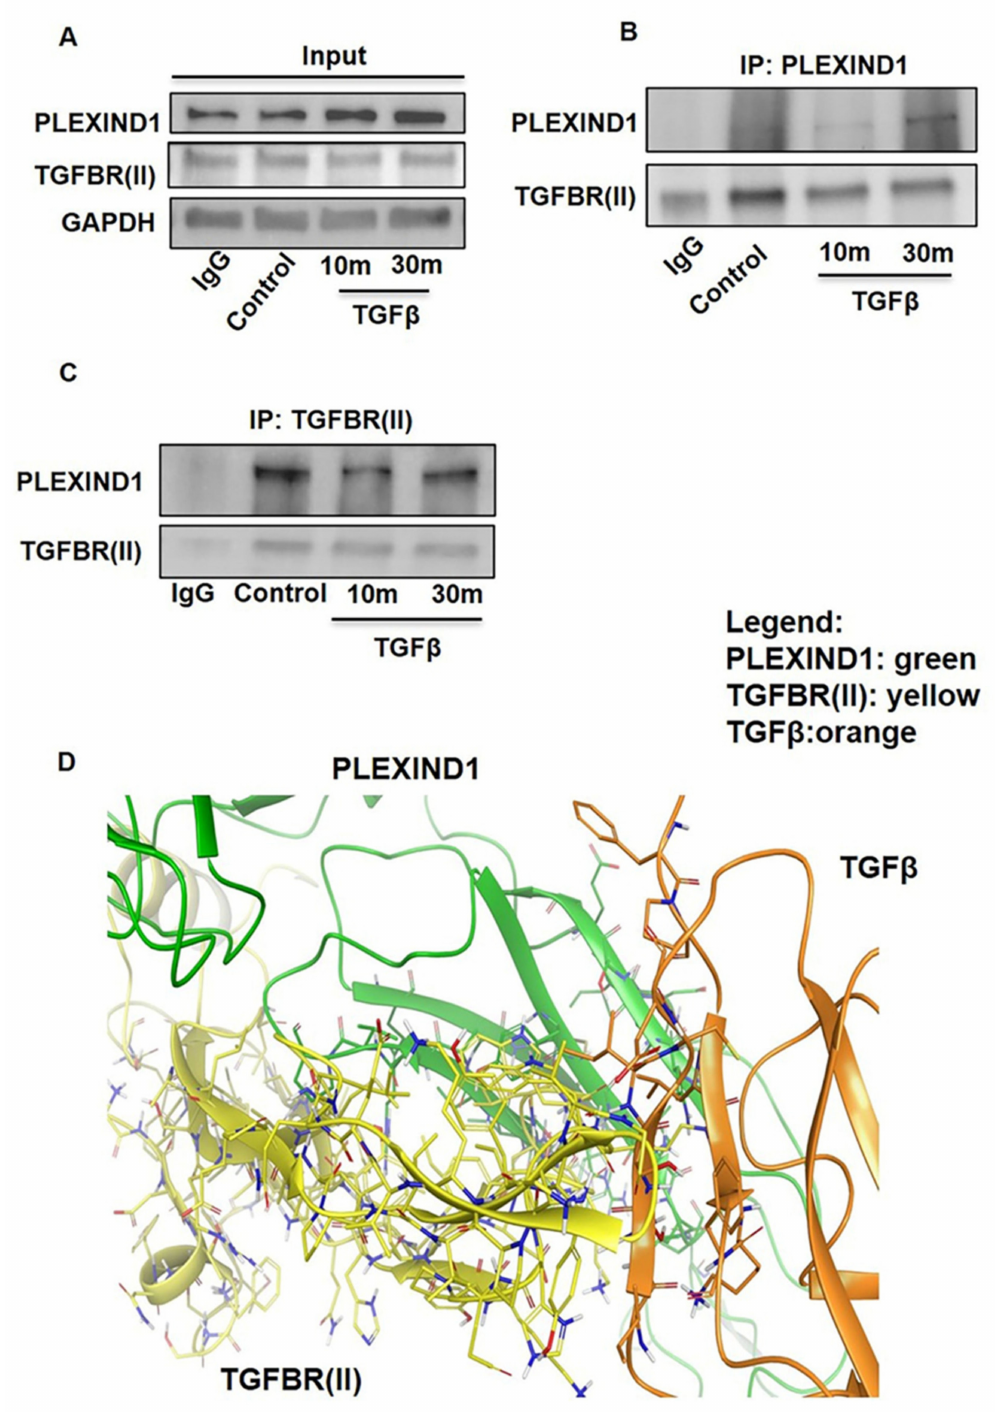
Figure 3. PLEXIND1 and TGF β RII can form an immuno-complex in PDAC. ( A ): Western blot analysis showing the input samples. ( B , C ): Co-immunoprecipitation assays showing that PLEXIND1 and TGFBRII are present in the same immunocomplex in PANC-1 cells. ( D ): Computational modeling analysis showing that PLEXIND1 and TGFBRII can form a complex in the presence of TGF β